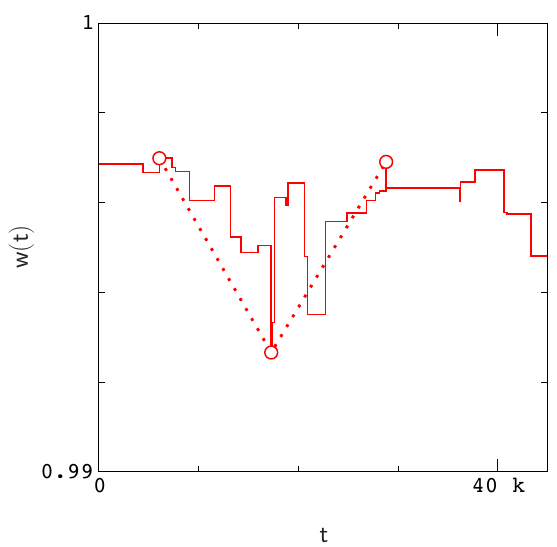
Figure A1. Fitness history of an allele between adjacent fixation events (solid line) sampled from a simulation with N = 10 3 and µ N = 1. Circles and dashed lines indicate the configuration of points which maximize the valley depth s = min { w i − w j , w k − w j }